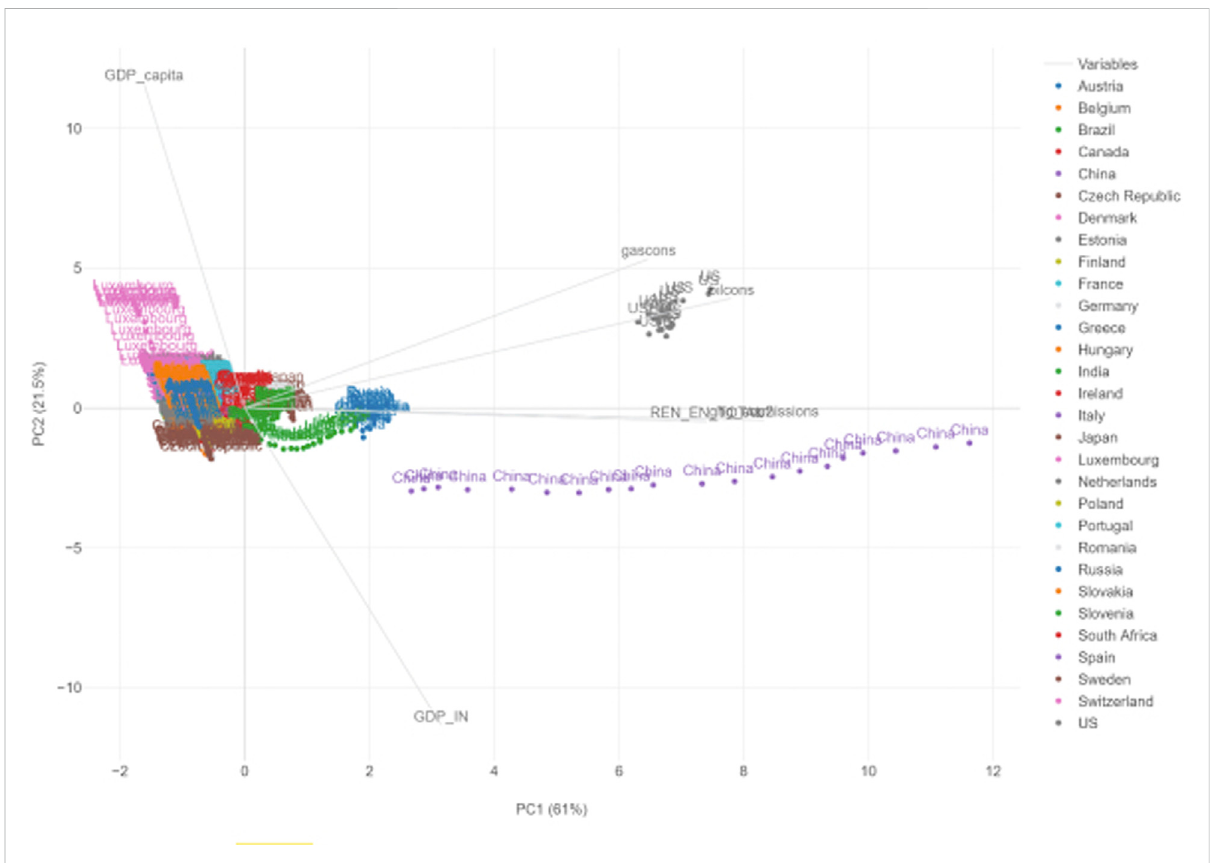
FIGURE 6 The dataset Principal Component